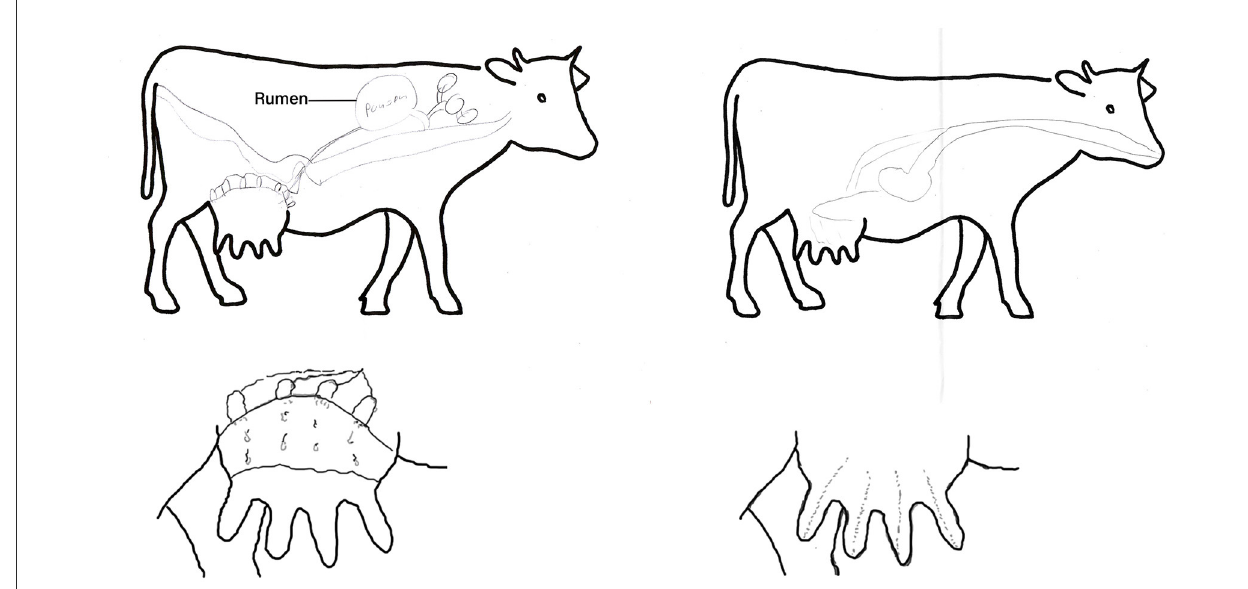
FIGURE9 Drawings by Mark [6th grade, 12 years; (left) ] and Michael [10th grade, 16 years; (right) ] of milk production in the body and udder of a cow.